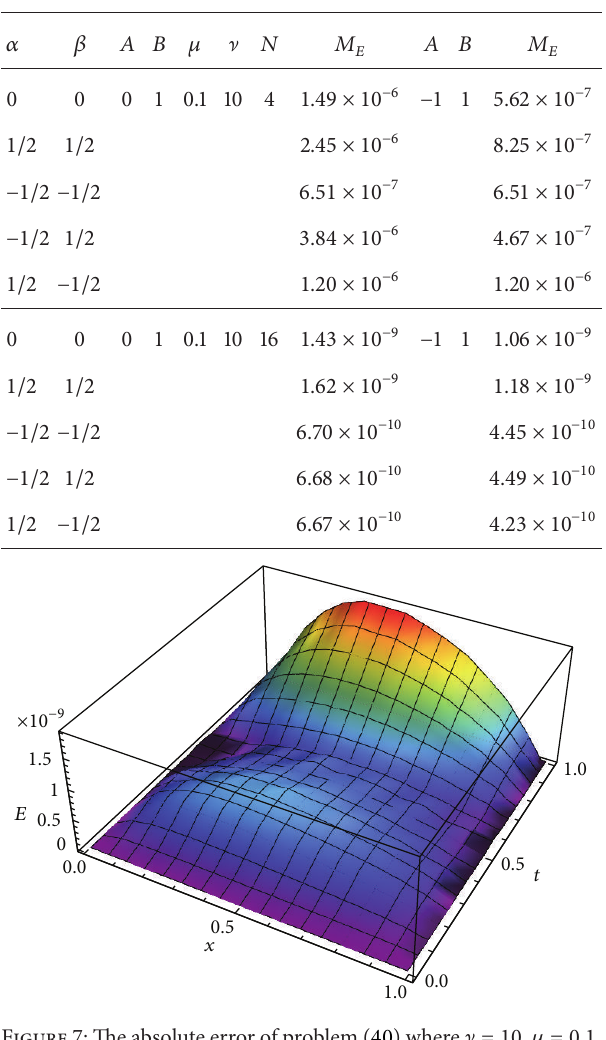
Table 5: Maximum absolute errors with various choices of (𝛼,𝛽) for Example 2.